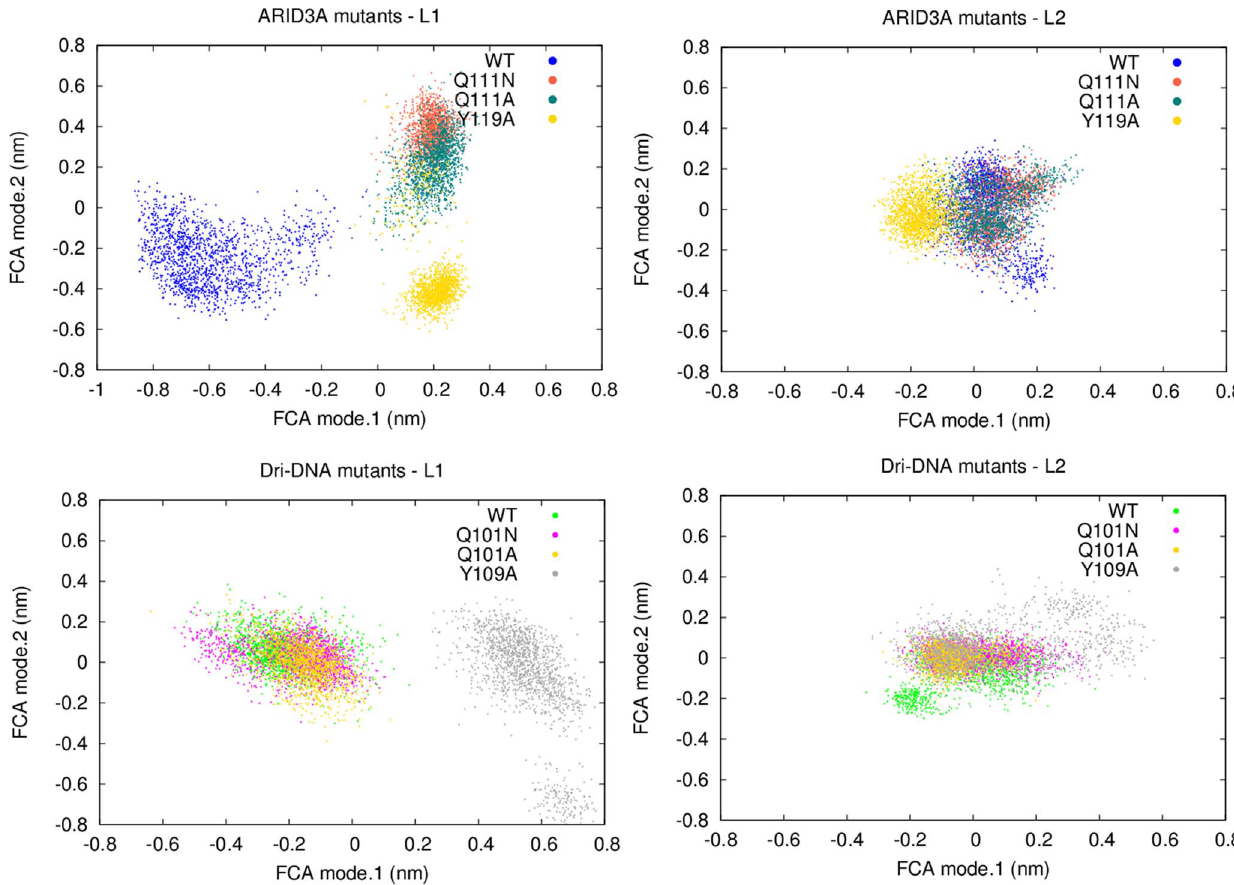
Figure 7. FCA modes of L1 and L2 in wt ARID3A FREE or Dri DNA and their mutants. Upper panels ) The two panels show the projection along FCA mode 1 and FCA mode 2 for L1 and L2 in ARID3A FREE and its mutants. ARID3A FREE , ARID3A Y119A , ARID3A Q111A and ARID3A Q111N are shown with different shade of colors. Bottom panels ) The two panels show the projection along FCA mode 1 and FCA mode 2 for L1 and L2 in Dri DNA and its mutants. Dri DNA , Dri Y119A , Dri Q111A and Dri Q111N are shown with different shade of colors. The projections report one replicate of each system, for sake of clarity. The same analysis was carried out for each combination of replicates of wild type and mutant variants and it provides similar results, as also expected by the high overlap in the essential subspace between individual replicates of the same system (root mean square inner product larger than 0.8).